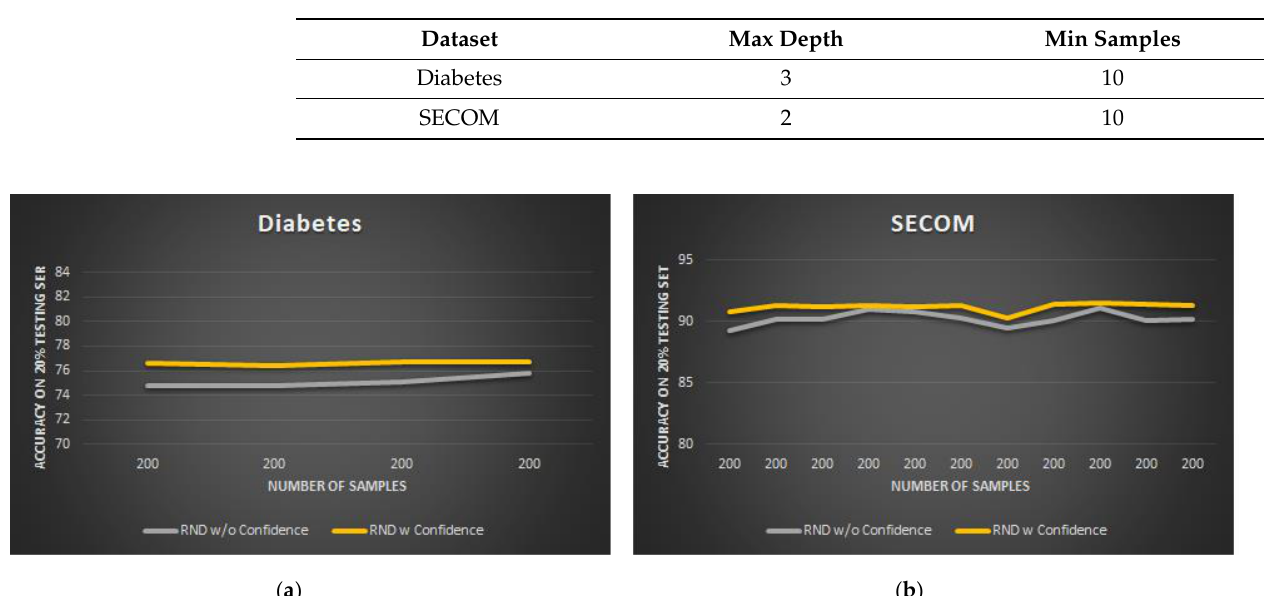
Figure 4. Learning Curves of AutoDT on ( a ) Diabetes and ( b ) SECOM datasets.